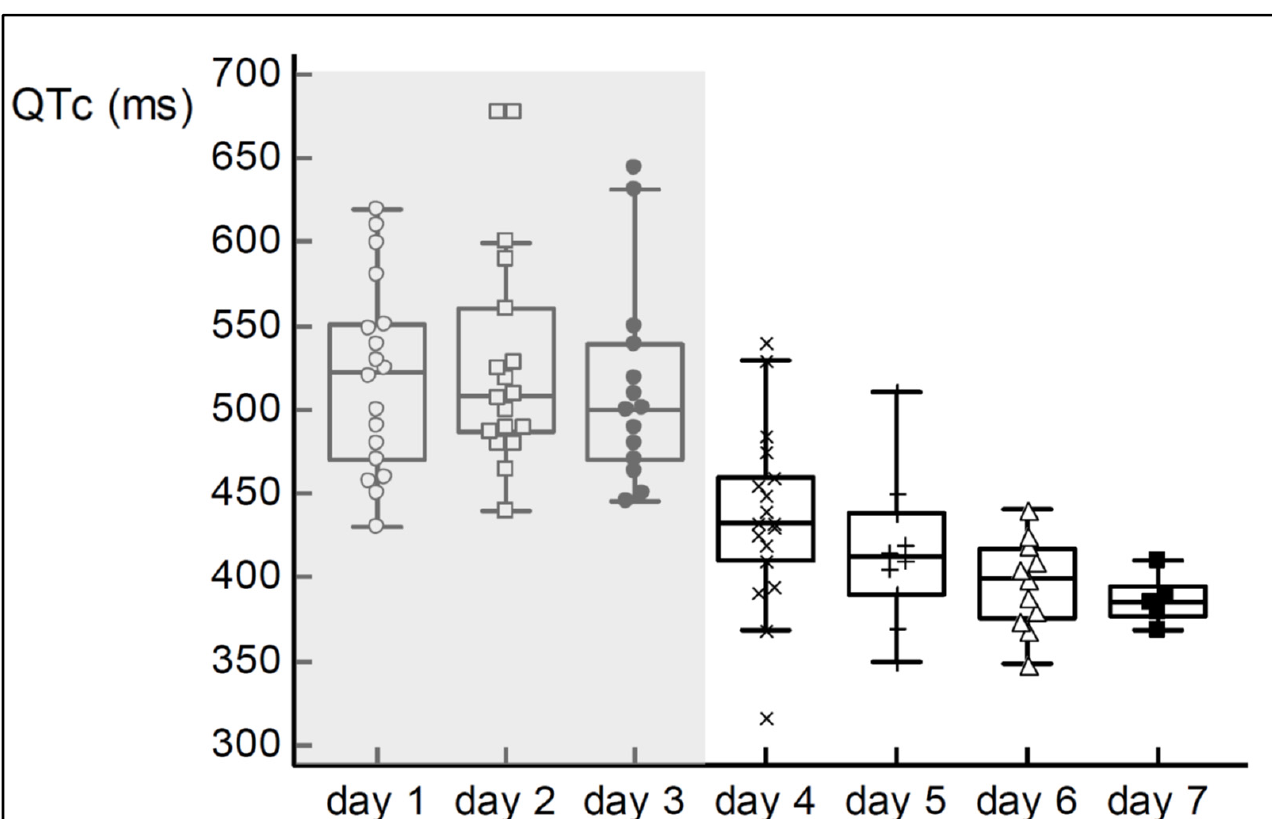
Figure 1. Pooled individual QTc intervals over postnatal age with 94 observations in 33 neonates (therapeutic hypothermia (light grey) day 1–3; normothermia (white), postnatal day 4–7), data from